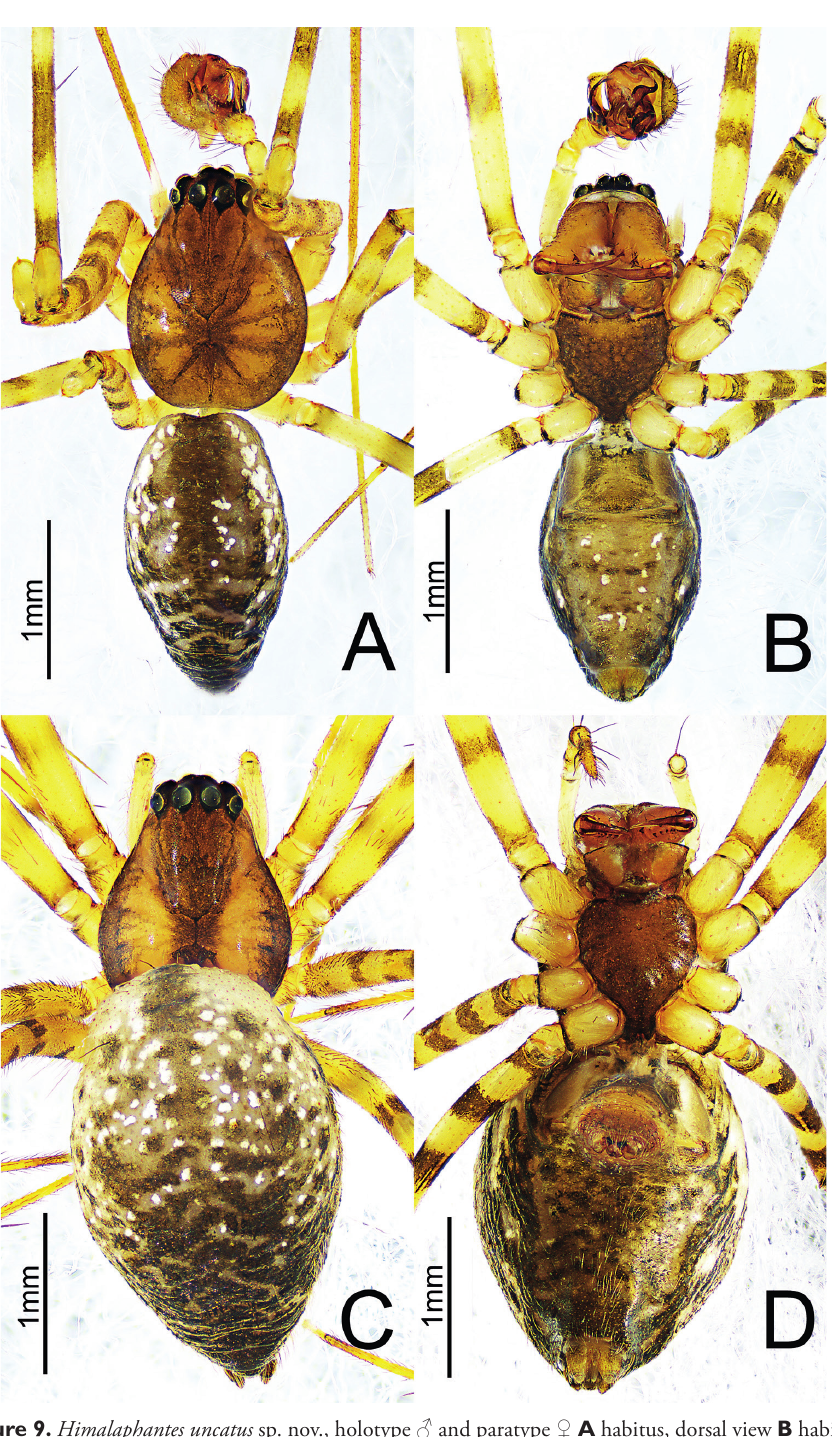
Figure 9. Himalaphantes uncatus sp. nov., holotype ♂ and paratype ♀ A habitus, dorsal view B habitus, ventral view C habitus, dorsal view D habitus, ventral